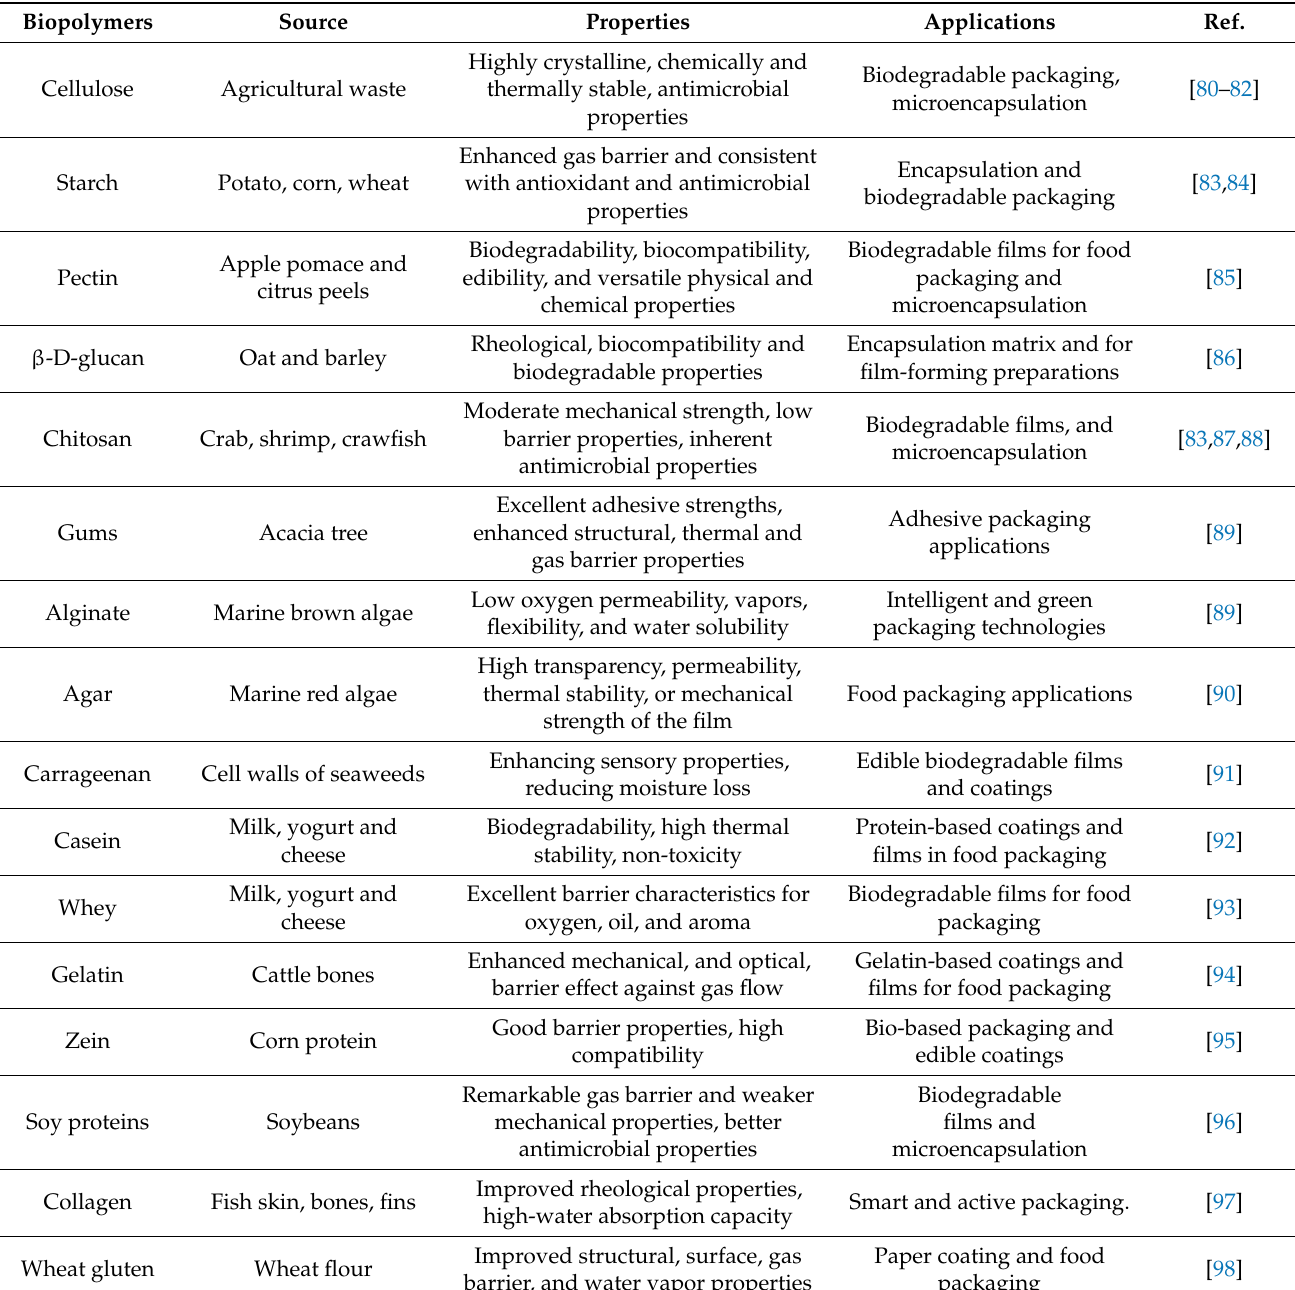
Table 1. Biopolymers with different properties used as packaging materials in the food